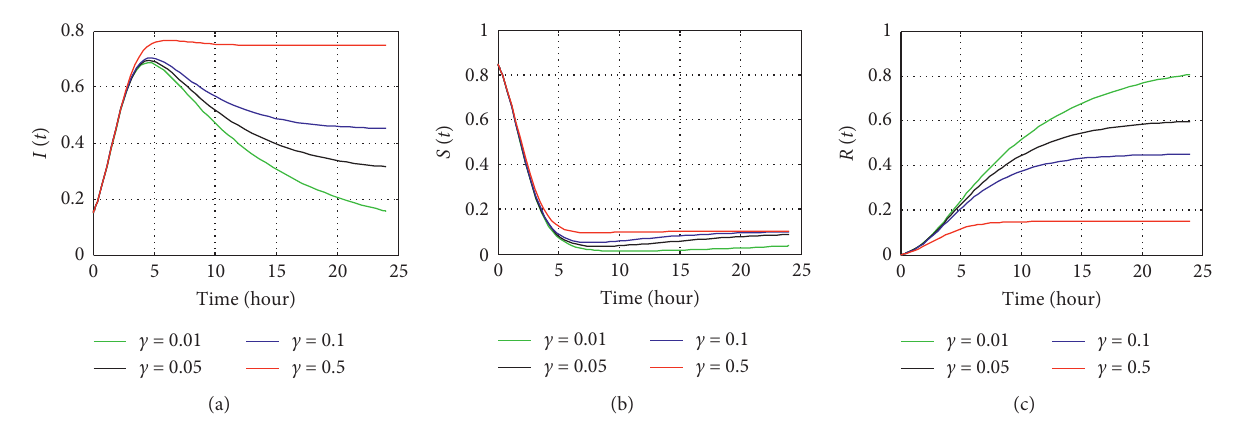
Figure 8: I ( t ) , S ( t ) , and R ( t ) under different c